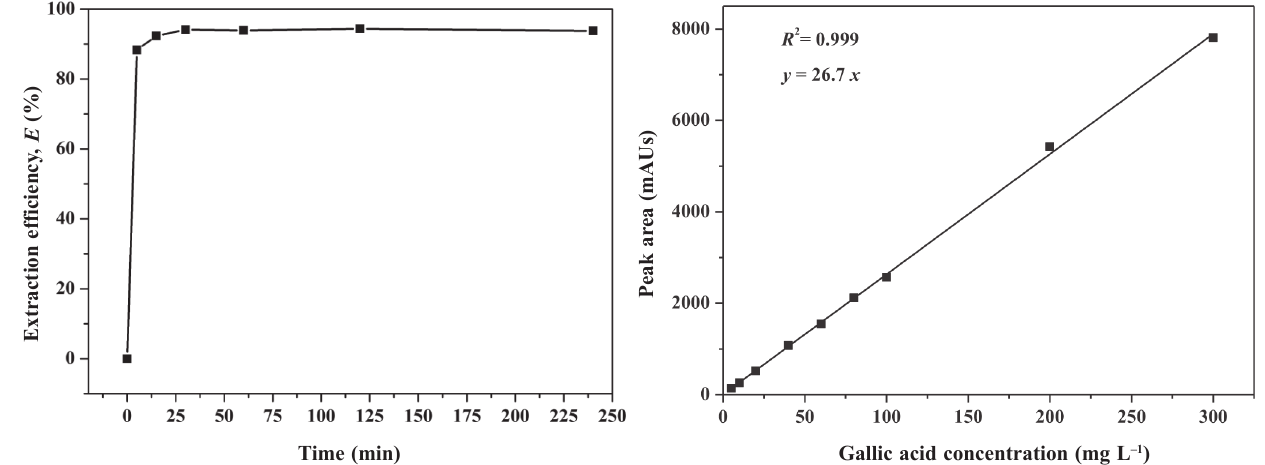
Fig. S1 – Experimental extraction efficiency (E%) of gallic acid versus time for the operating conditions: C C = 40 % (v/v), T = 30 o C, pH TBP